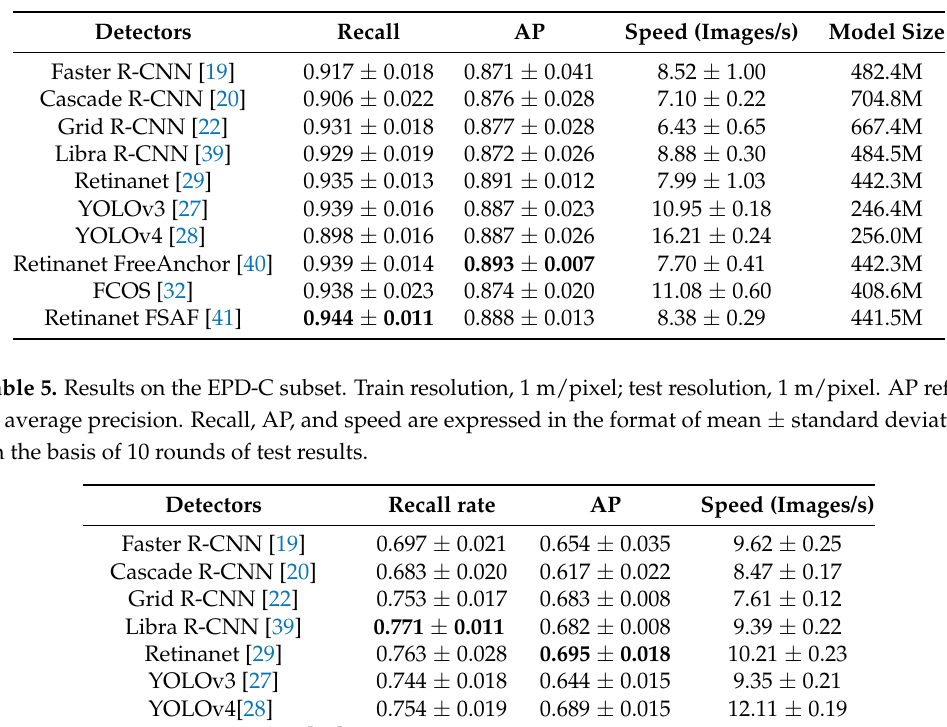
Table 4. Results on the EPD-S subset. Train resolution, 1 m/pixel; test resolution, 1 m/pixel. AP refers to average precision. Recall, AP, and speed are expressed in the format of mean ± standard deviation on the basis of 10 rounds of test results.